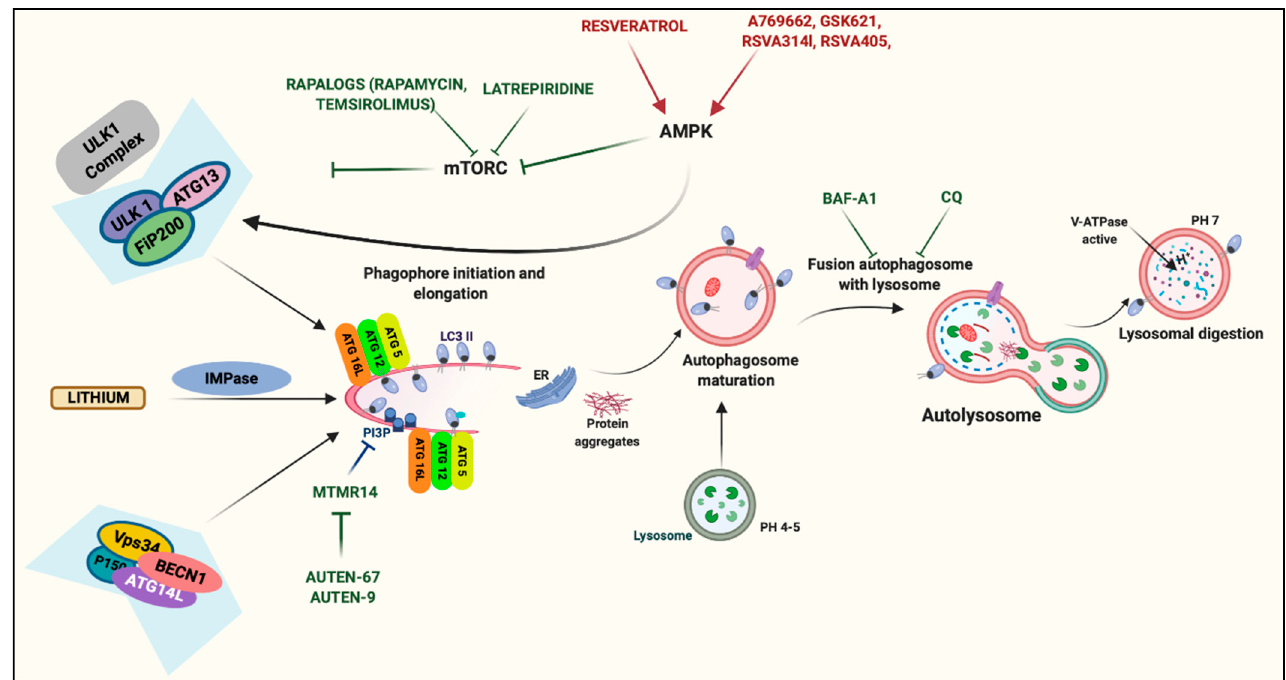
Figure 3. Strategies for targeting autophagy in neurodegeneration.